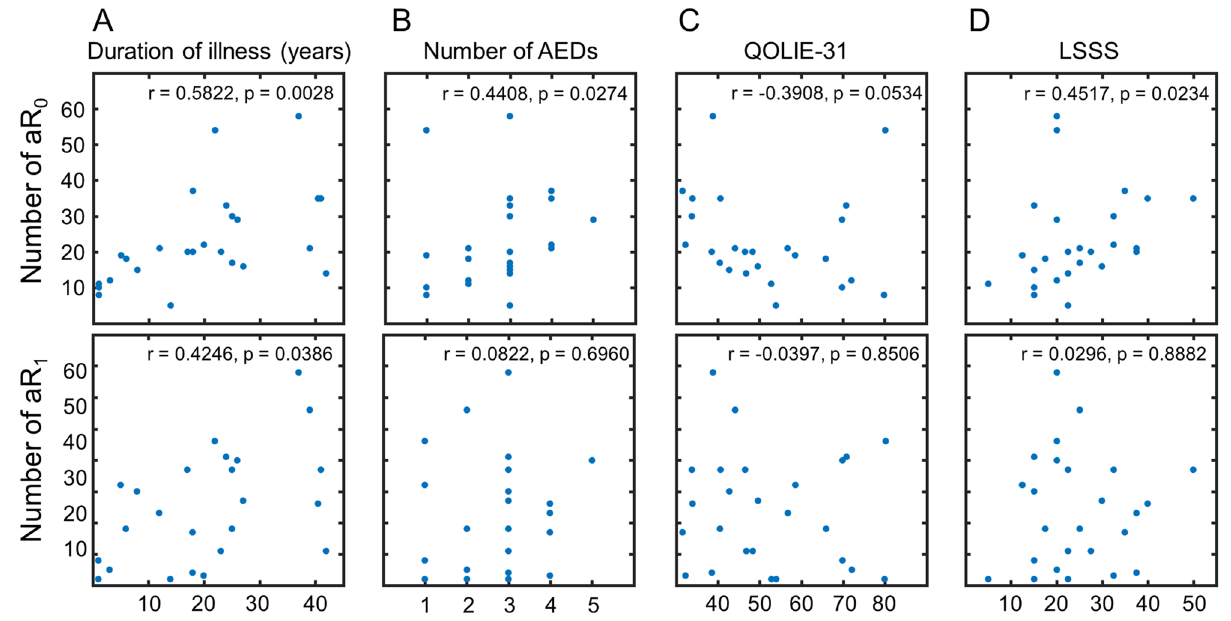
Figure 3. Number of abnormal regions were associated with various clinical parameters. Spearman’s partial correlation analysis with age as nuisance covariate showed that the numbers of aR 0 and aR 1 were related to the duration of illness (r = 0.5822, p = 0.0028; r = 0.42646, p = 0.0386, respectively) ( A ). The number of aR 0 also was related to the number of AEDs ( B ) and LSSS ( D ). AED anti-epileptic drug, QOLIE Quality of life in Epilepsy Inventory, LSSS Liverpool Seizure Severity